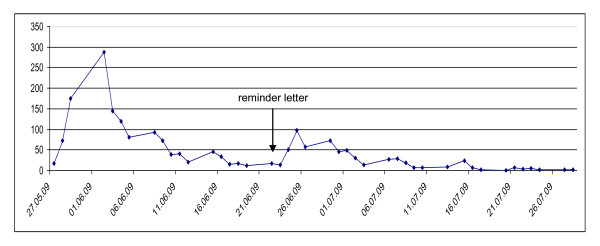
Number of questionnaires returned during the study period.